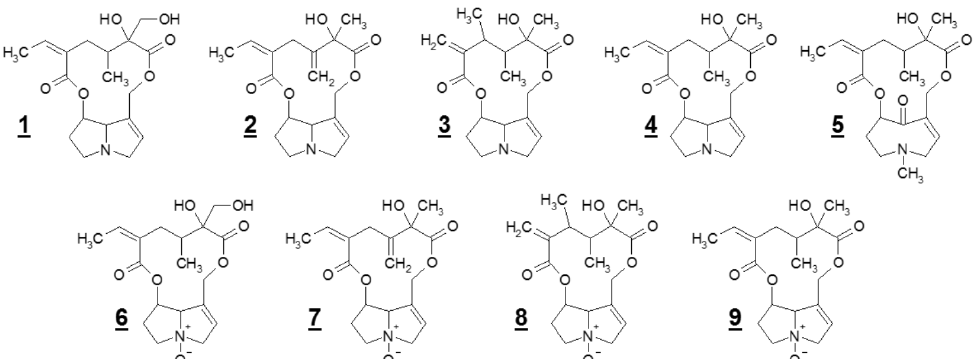
Figure 1. Chemical structures of the nine pyrrolizidine alkaloids (PAs) detected in Senecio vulgaris